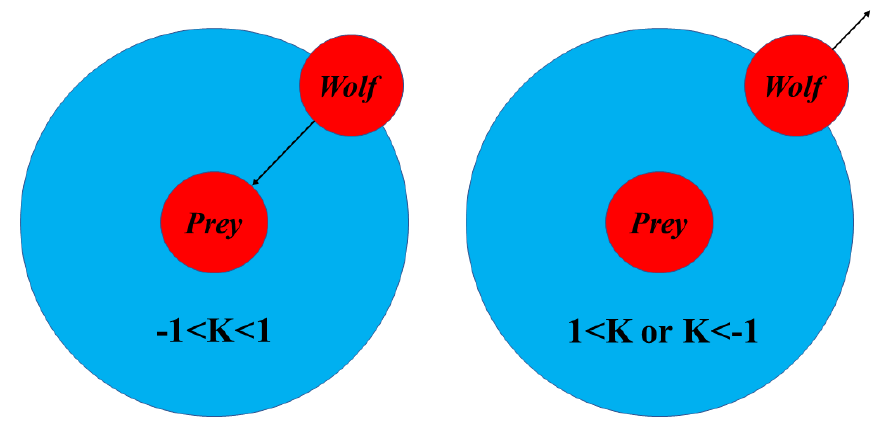
Figure 6. Search neighborhood.